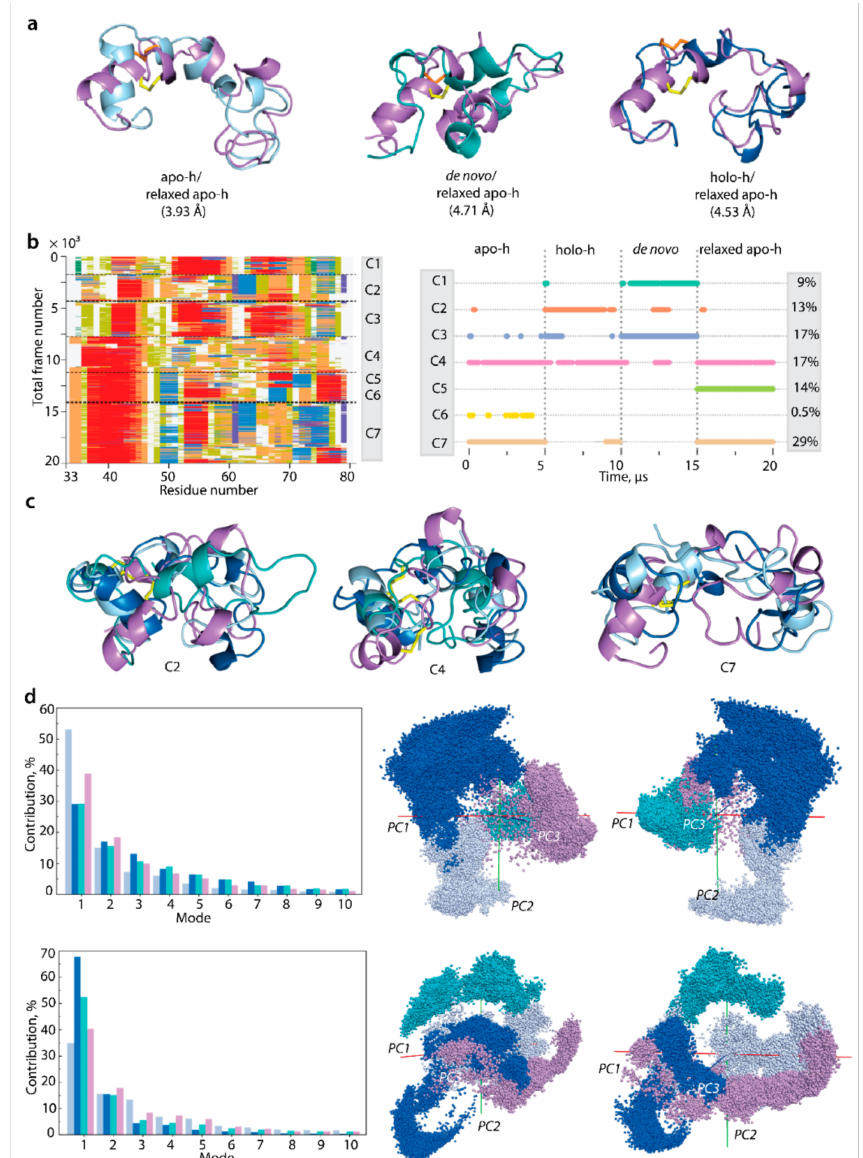
Figure 8. Clustering of MD conformations of L-loop simulated as an isolated polypeptide cleaved from each form—apo-h holo-h, relaxed apo-h, and de novo model. ( a ) Conformations with the lowest RMSD values (<4.0 and 5.0 Å, shown in parentheses) are superimposed. ( b ) Secondary structures- based clustering [23] with threshold 0.65 (left) performed on the time-depended evolution of each L-loop form secondary structures as assigned by DSSP: α -helix is in red, 3 10 -helix is in blue, turn is in orange, and bend is in dark yellow. Population and composition of clusters (right). The simulation time is displayed as cumulative for four trajectories. ( c ) Superimposition of L-loop from the most populated clusters C2, C4, and C7, composed of conformations generated from at least three different forms ( b ). ( d ) PCA analysis of concatenated cMD trajectories of cleaved L-loop simulated with constrained N- and C-ends (top panel) and without constraints (bottom panel). The bar plot gives the eigenvalue spectra in descending order for the first 10 modes calculated on each cMD trajectory (left). Projection of L-loop cMD conformations onto the first three principal components (PC) (right). The concatenated trajectories were least-square fitted on the mean conformation to remove rigid-body motions. ( a – d ) L-loop from apo-h (blue light), holo-h (blue dark), relaxed apo-h (lilac), and de novo (teal) is shown as cartoon with helices and disulfide bridges in yellow